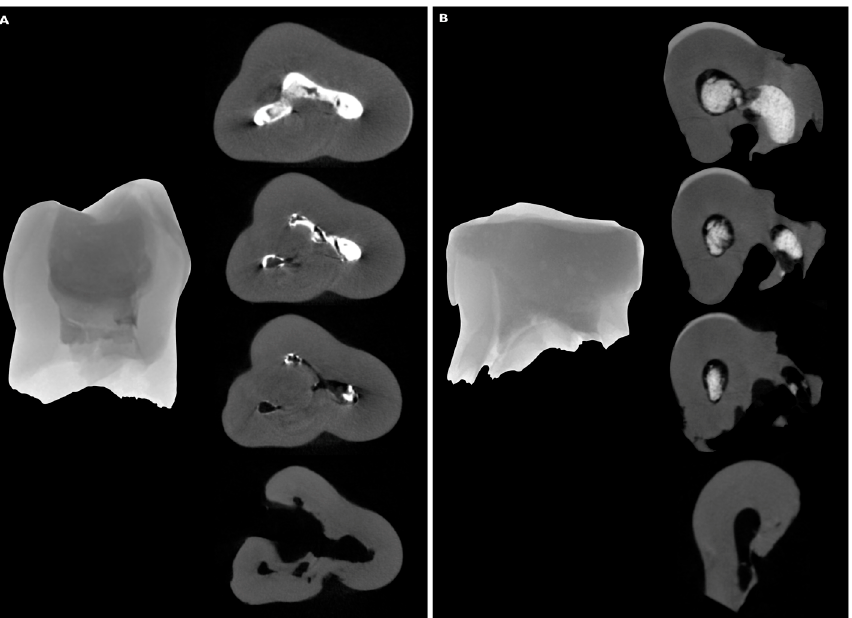
Figure 4. The representative images of the two scanned molars ( A , B left) and their cross-sectional images ( A , B right) at the different levels of the resorbed roots, demonstrating the presence/absence of the ER filler inside the root canal space.